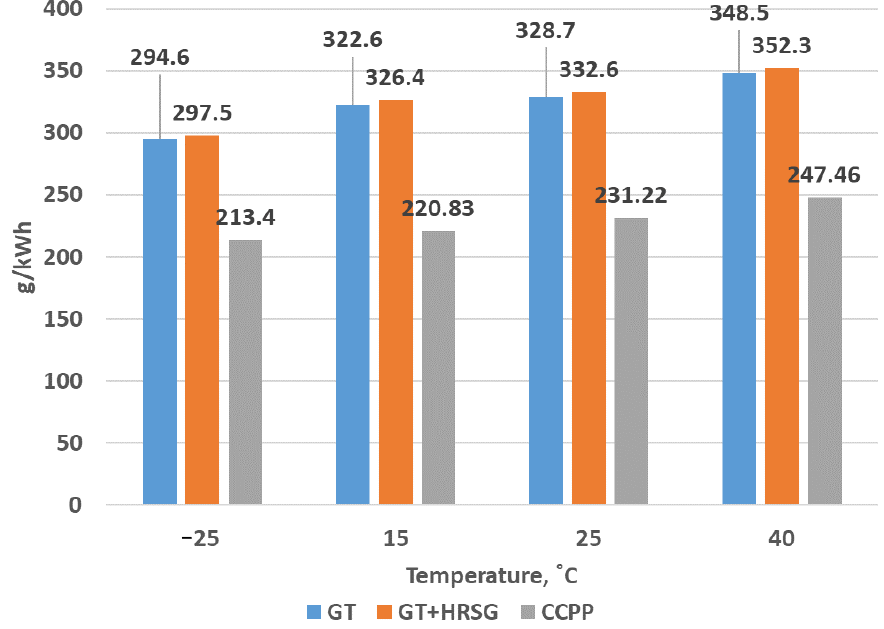
Figure 11. Specific fuel consumption for electricity production.